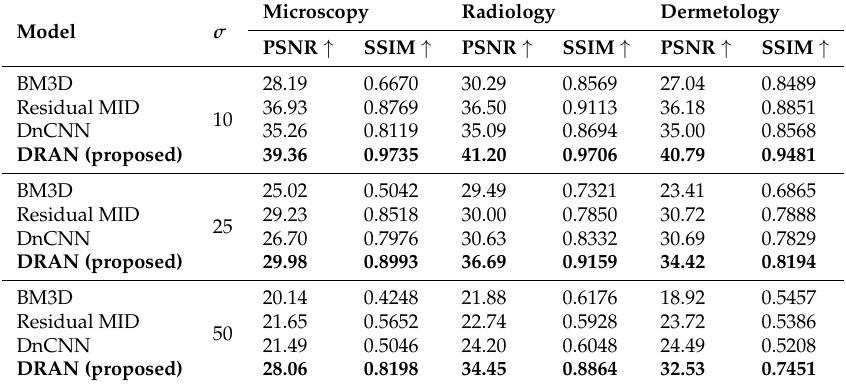
Table 2. Quantitative comparison between different medical image denoising methods. Results are obtained by calculating the mean on two evaluation metrics. In all comparing categories, the proposed method illustrates the consistency and outperforms the existing denoising